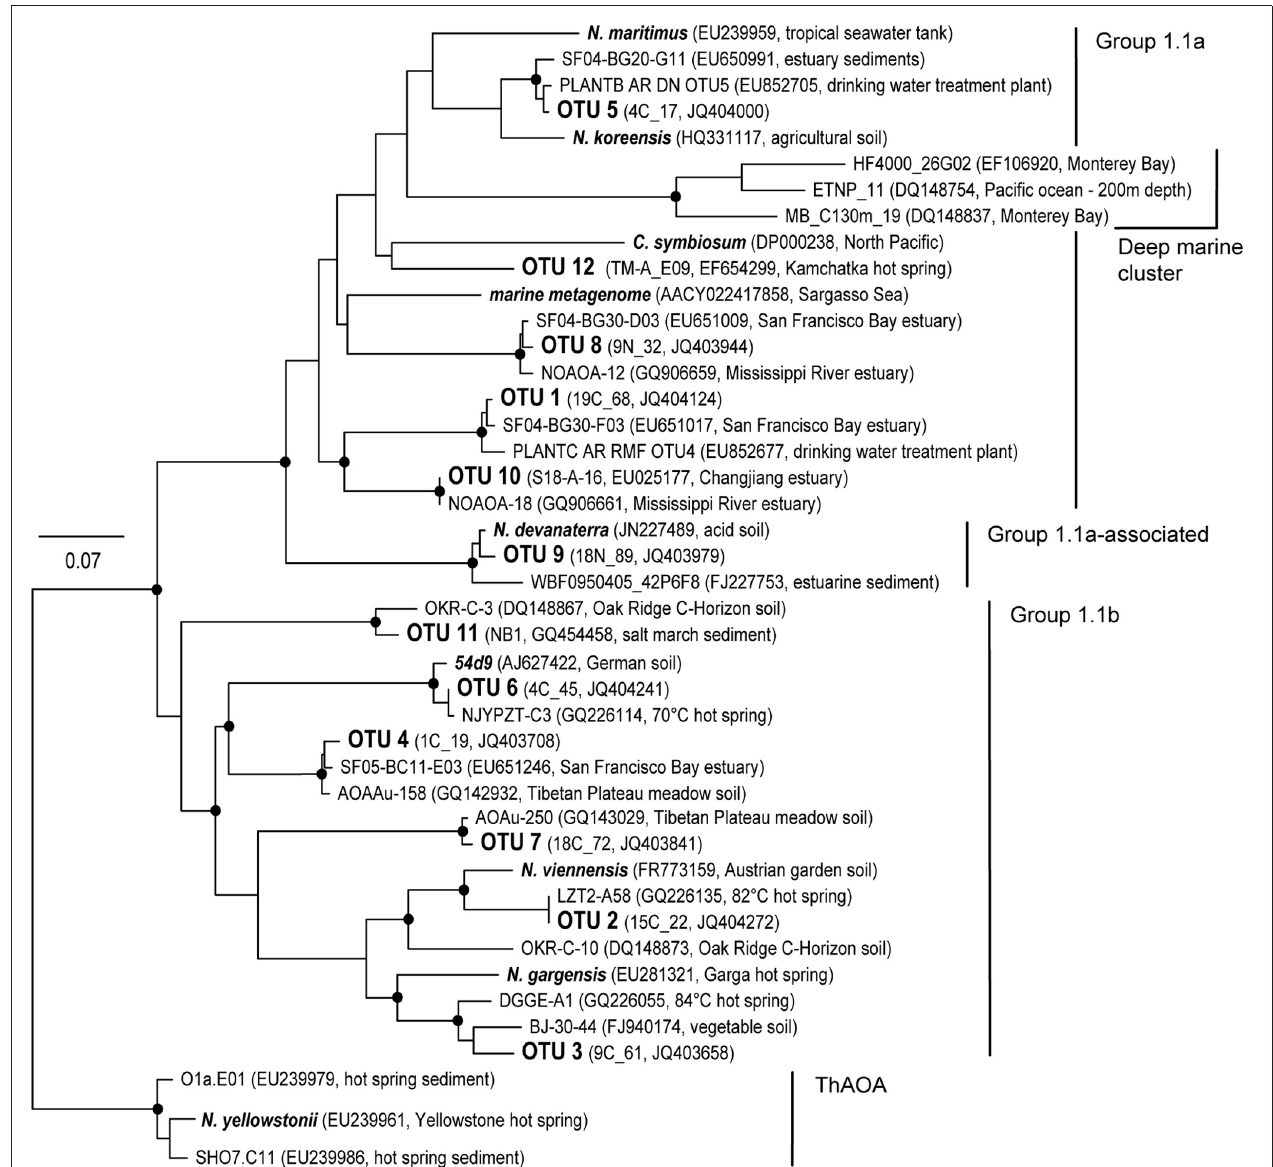
FIGURE 6 | Neighbor − joining tree based on 1737 amoA gene fragments (484 unambiguously aligned positions); only sequences from the work described here as well as selected reference sequences are shown. Representative amoA sequences for phylotype codes (OTUs) defined at 15% nucleotide sequence dissimilarity found in this study are indicated in large font. Phylotype codes are followed by names of representative clones of the amoA library and the accession number in brackets. Phylotypes which were